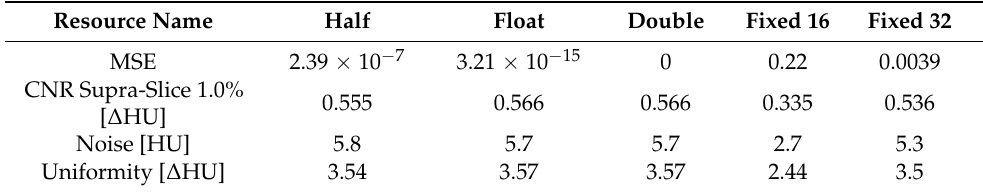
Table 3. Image quality estimation of different data format configurations.